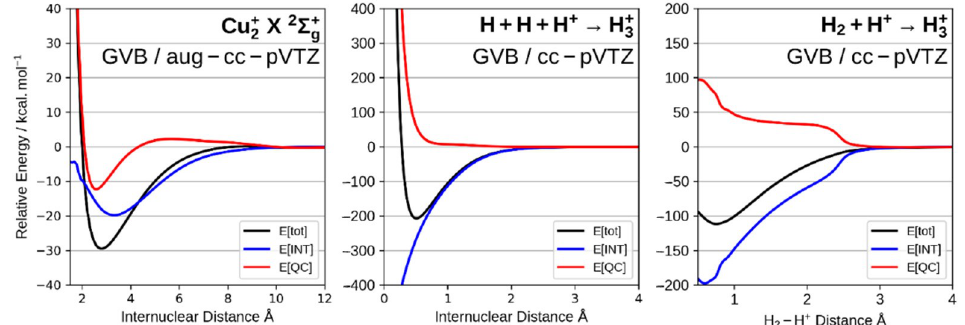
Figure 2. Energy partitioning into interference and quasi-classical contributions along the potential energy surfaces (PES) for Cu 2+ (2c-1e) and for H 3+ (3c-2e).